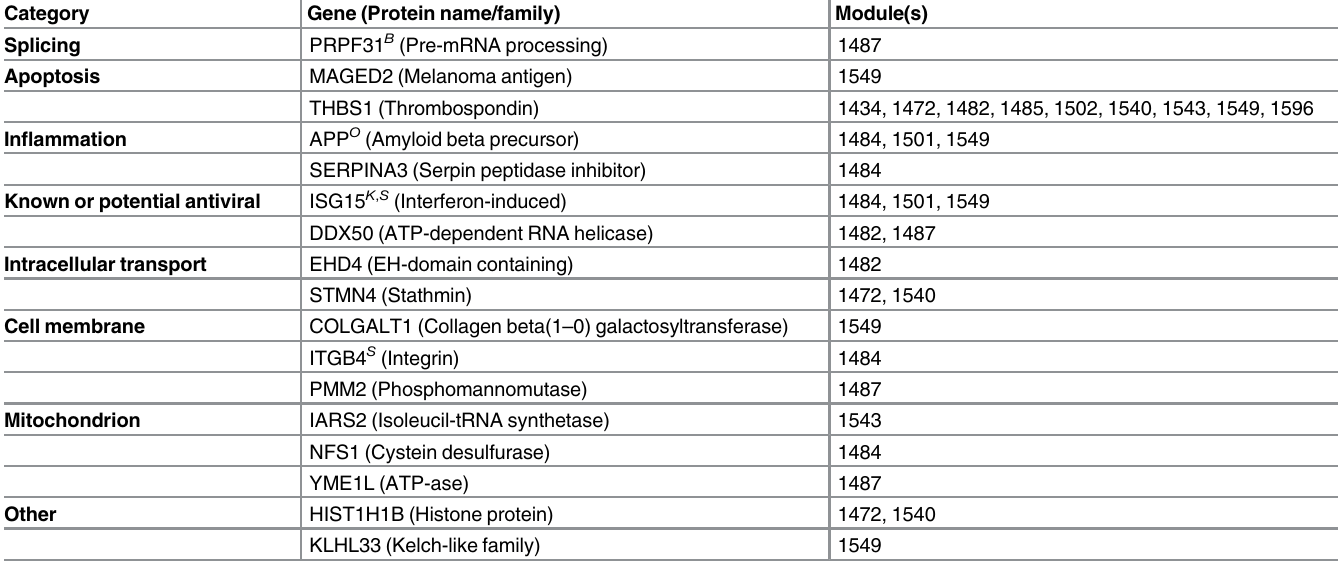
Table 3. Consensus human protein regulators identified by